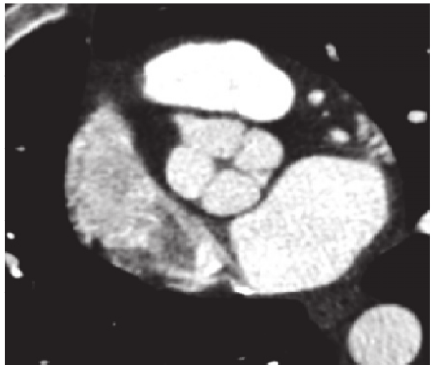
Figure 2: Heart CTA showing